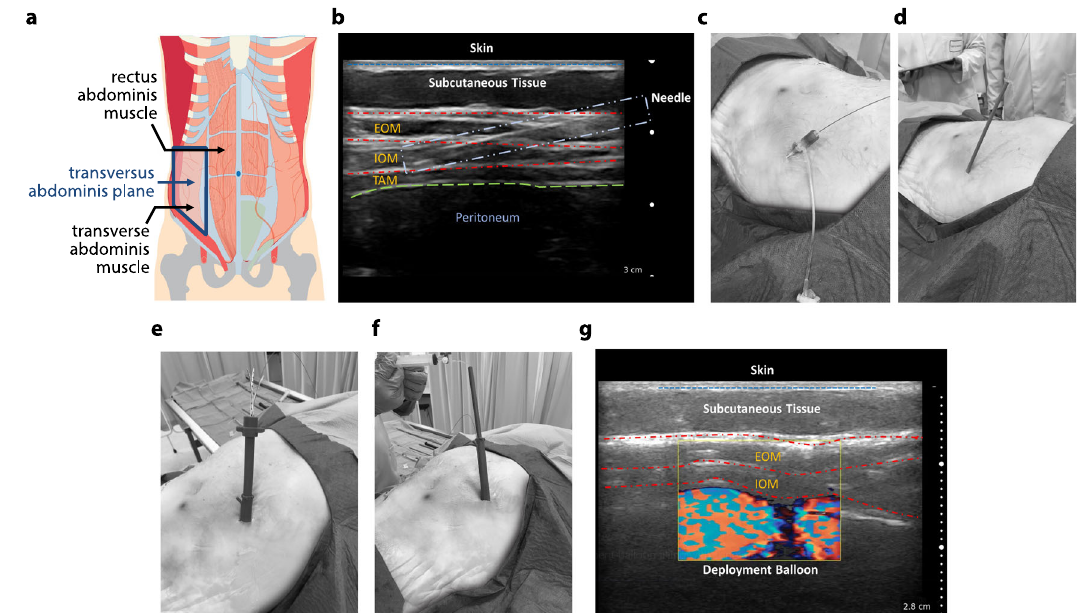
transversus abdominis plane and a 5 Fr sheath was exchanged over a guide wire to maintaindurableaccesstothetissueplane. d Acommerciallyavailabledilatorsetis used to expand the space to accommodate positioning of the deployment sheath. e STAR advancement through sheath into tissue space. f , g An echogenic contrast agentwasused to in fl ate the deployment channeltoensurecompleteunfolding of the STAR device within the plane using ultrasound